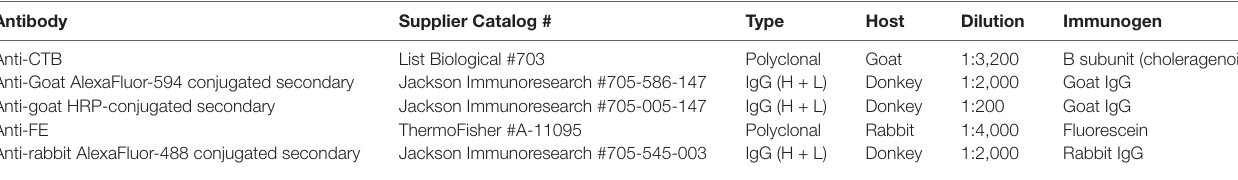
TABLE 2 | Antibodies used for immunofluorescence and immunohistochemistry.